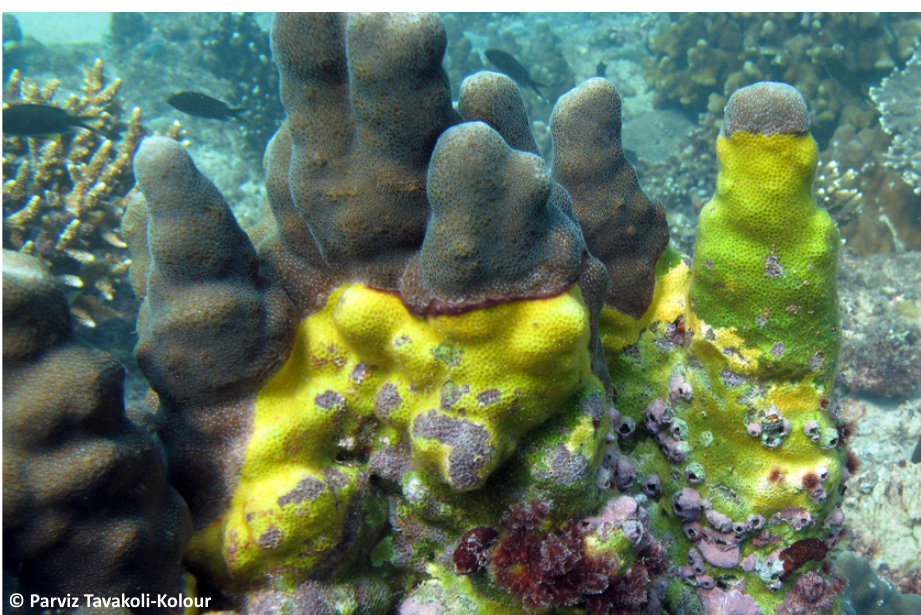
Image 3. Red band disease on Porites species.